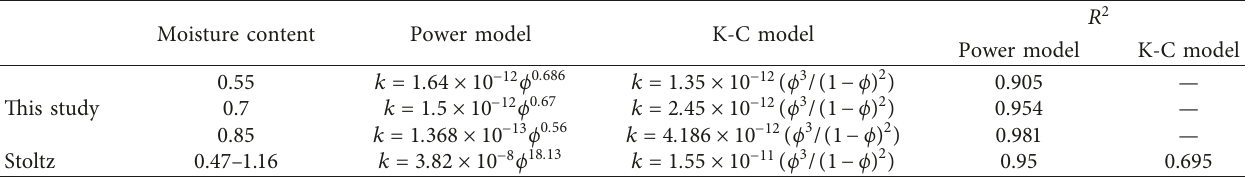
Figure 9: Power model and K-C model fit intrinsic permeability and porosity of MSW. Table 3: Parameters for the fitting formula of intrinsic permeability and porosity.